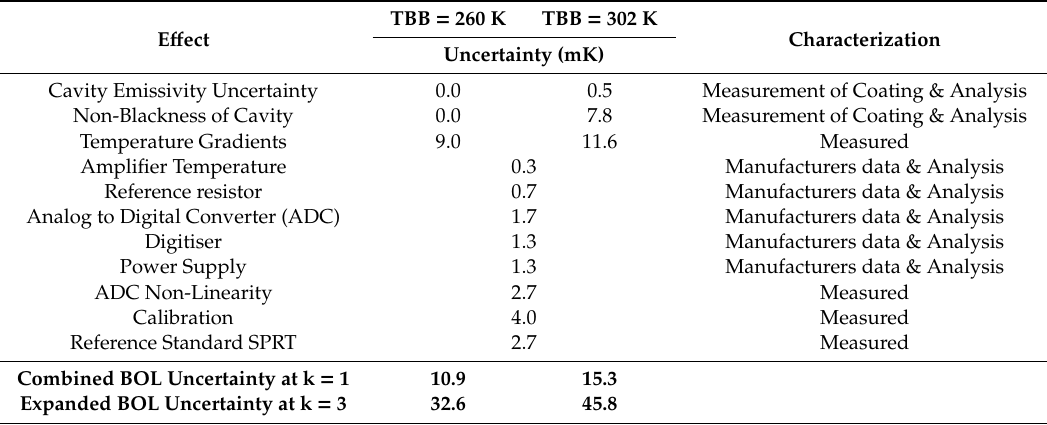
Table 4. Although the End-of-Life (EOL) budgets meet the requirement for SST measurement, these are predicted estimates and do not guarantee traceability to ITS-90. Table 3. SLSTR-A blackbody uncertainties before launch for the 10.8 um